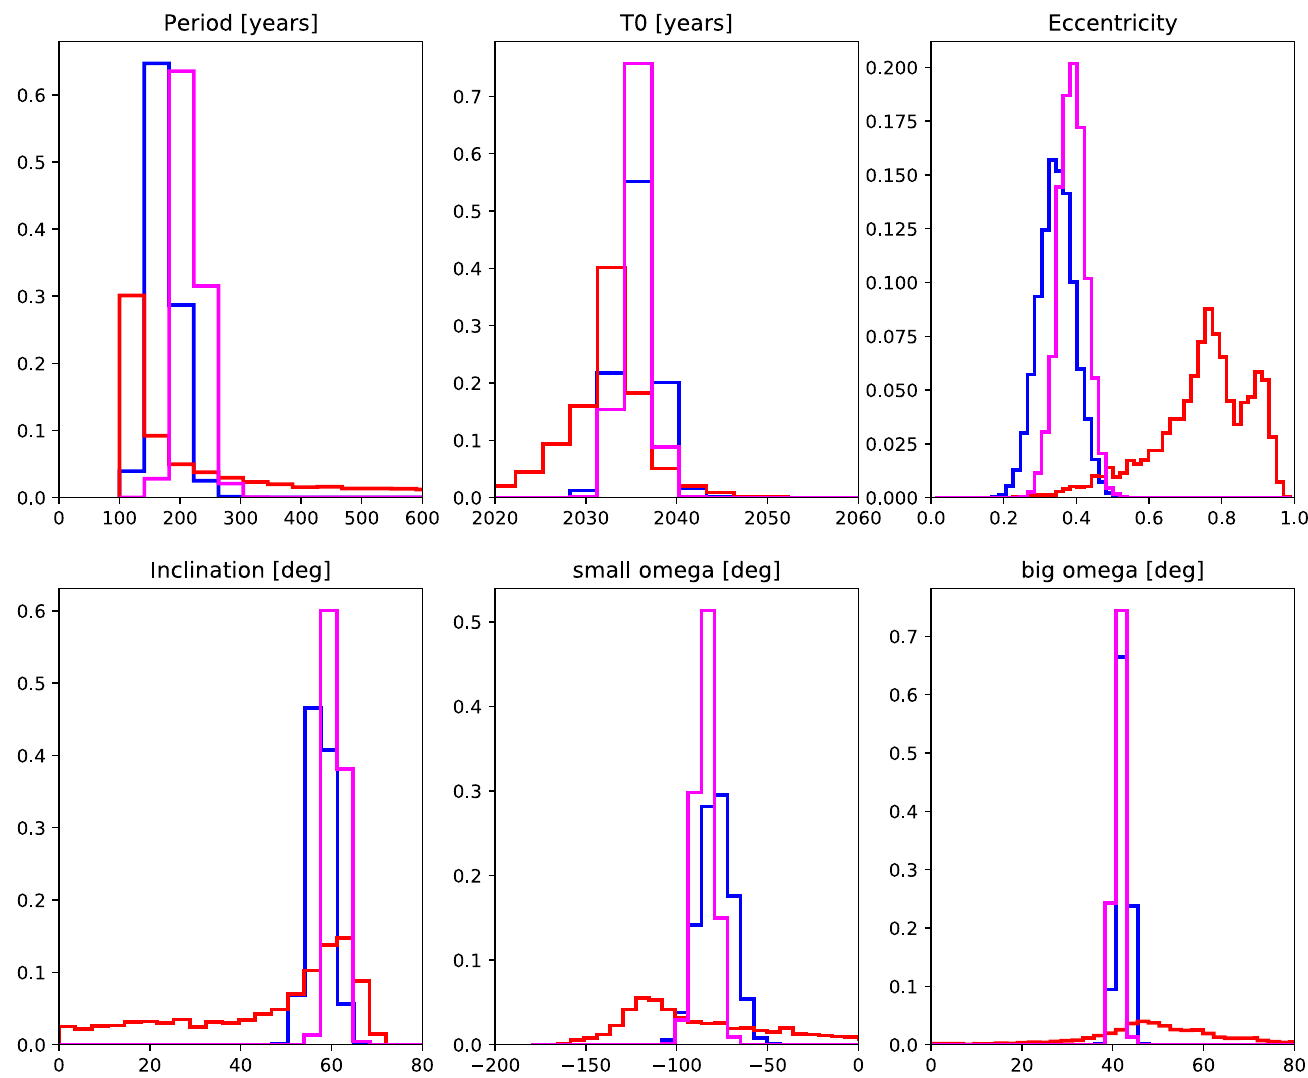
Figure 16. Orbital parameters for different data sets: OSIRIS-only orbit in blue, OSIRIS plus NIRC2 orbit in magenta, and NIRC2-only in red. Note that the NIRC2- only orbit does not have any RV information, and it provides poor constraints on several